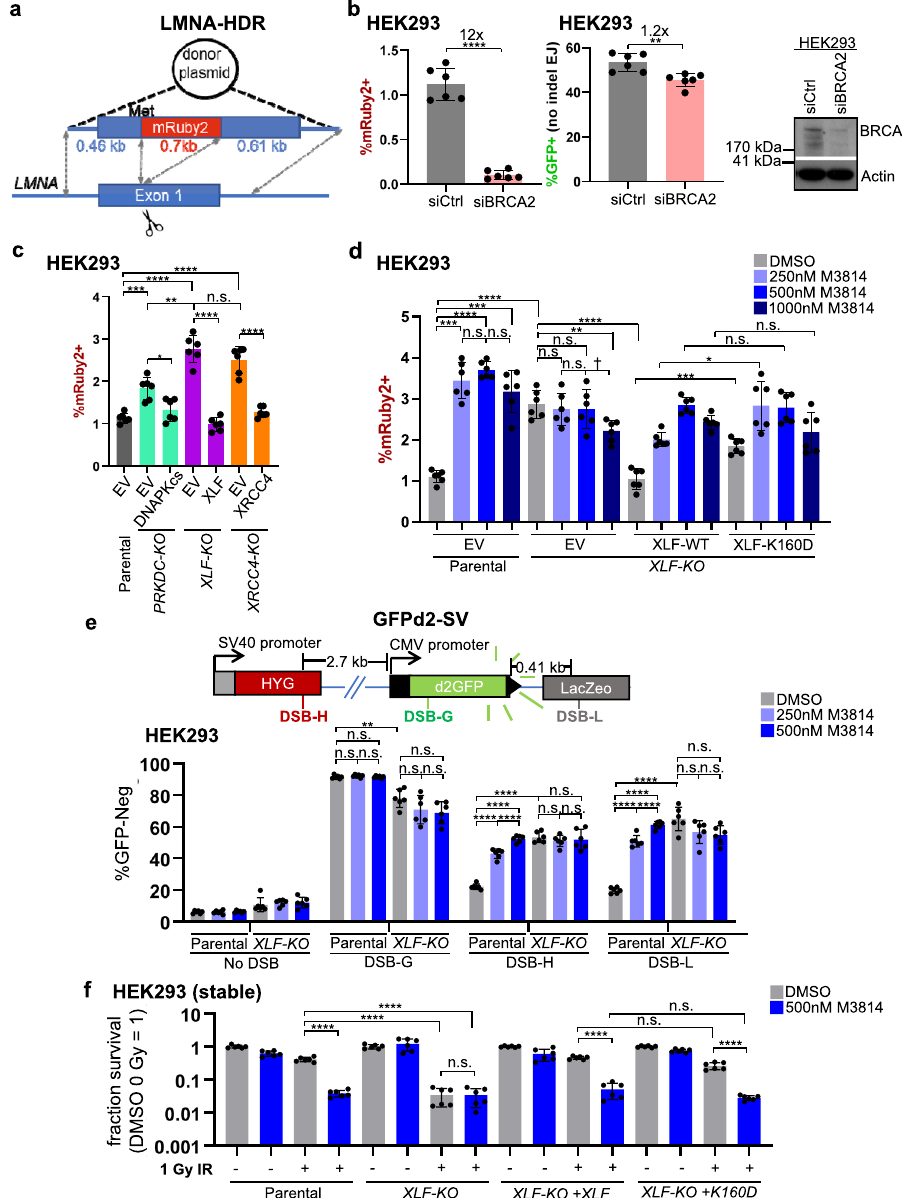
Fig. 6 DNAPKcs kinase inhibition causes an increase in HDR and structural variants (SVs), and IR sensitivity that is not further enhanced by XLF loss. a Shown is the LMNA-HDR reporter (not to scale) involving a Cas9/sgRNA that induces a DSB in LMNA exon 1, and a plasmid donor such that HDR causes mRuby2 to be expressed from the LMNA locus. The mRuby2 frequencies are normalized to transfection ef fi ciency with parallel GFP transfections. b BRCA2 is required for HDR by the LMNA-HDR assay, but has modest effects on No Indel EJ. Cells were transfected with siRNA that is non-targeting (siCtrl) or targets BRCA2 (siBRCA2). n = 6 biologically independent transfections. Statistics with unpaired two-tailed t test using Holm – Sidak correction. **** P < 0.0001, ** P = 0.00305. Immunoblot shows levels of BRCA2. c DNAPKcs, XLF, and XRCC4 suppress HDR to similar degrees. n = 6 biologically independent transfections. Statistics as in ( b ). **** P < 0.0001, *** P = 0.00069, ** P = 0.00117, n.s. not signi fi cant. d Suppression of HDR. n = 6 biologically independent transfections. Statistics as in ( b ). **** P < 0.0001, Parental EV DMSO vs. 1000 nM M3814 *** P = 0.000493, XLF-KO XLF-WT DMSO vs. XLF- K160D DMSO *** P = 0.000404, XLF-KO EV DMSO vs. 1000 nM M3814 ** P = 0.0203, XLF-KO XLF-WT 250 nM M3814 vs XLF-K160D 250 nM M3814 * P = 0.0249, † P = 0.0386 but not signi fi cant after correction (unadjusted P -value), n.s. not signi fi cant. e Suppression of SVs. Shown is the GFPd2-SV reporter (not to scale) that is chromosomally integrated to an FRT site in HEK293 cells. Stable expression of Cas9 and various sgRNAs (DSB-H, DSB-G, and DSB-L) can induce GFP-negative cells (GFP-neg). n = 6. Statistics as in ( b ). **** P < 0.0001, ** P = 0.00136, n.s. not signi fi cant. f IR sensitivity. HEK293 stable cell lines were treated with DMSO or M3814, and 0 Gy or 1 Gy IR dose, and plated to form colonies. Fraction clonogenic survival was determined relative to DMSO 0 Gy for each cell line. n = 6 biologically independent wells of seeded cells. Statistics as in ( b ). **** P < 0.0001, n.s. = not signi fi cant. Error bars = SD. Data are represented as mean values ± SD.